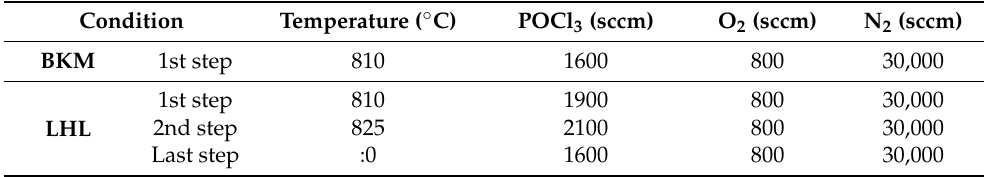
Table 1. Process parameters of BKM and LHL diffusion processes for p-type mc-Si solar cells.